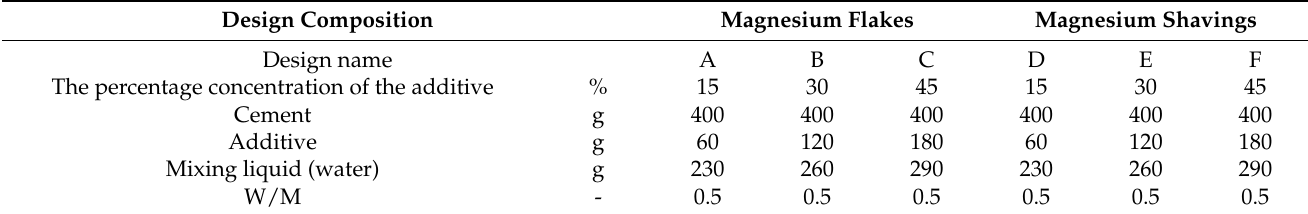
Table 1. Composition of individual designs.